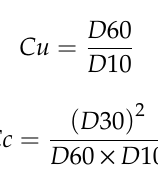
Figure 13. Particle radius distribution of mixed material.